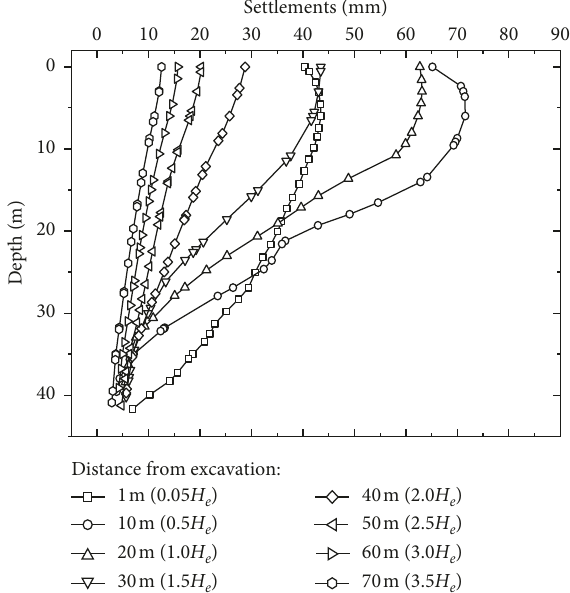
Figure 2: Regular deep soil settlement at different distances from excavation.